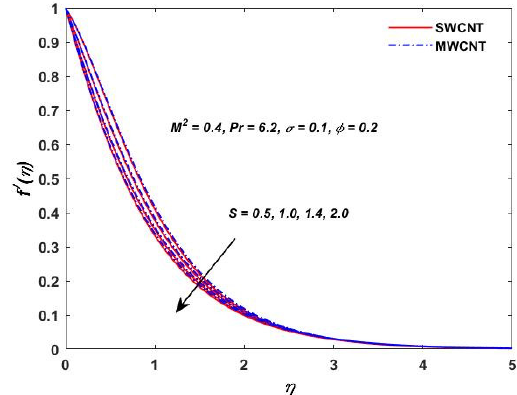
Figure 5. Volume fraction verses velocity 𝑔(𝜂).